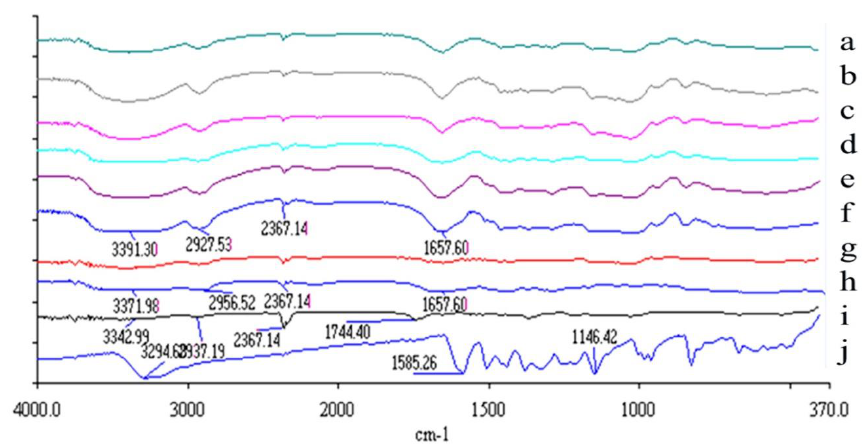
Figure 4. Fourier transform infrared (FTIR) spectra for resveratrol, PVP, HPBCD, and di ff erent formulations (Res:PVP:HPBCD) of resveratrol nanofibers. ( a ) 1:16:40, ( b ) 1:8:40, ( c ) 1:4:40, ( d ) 1:16:20,